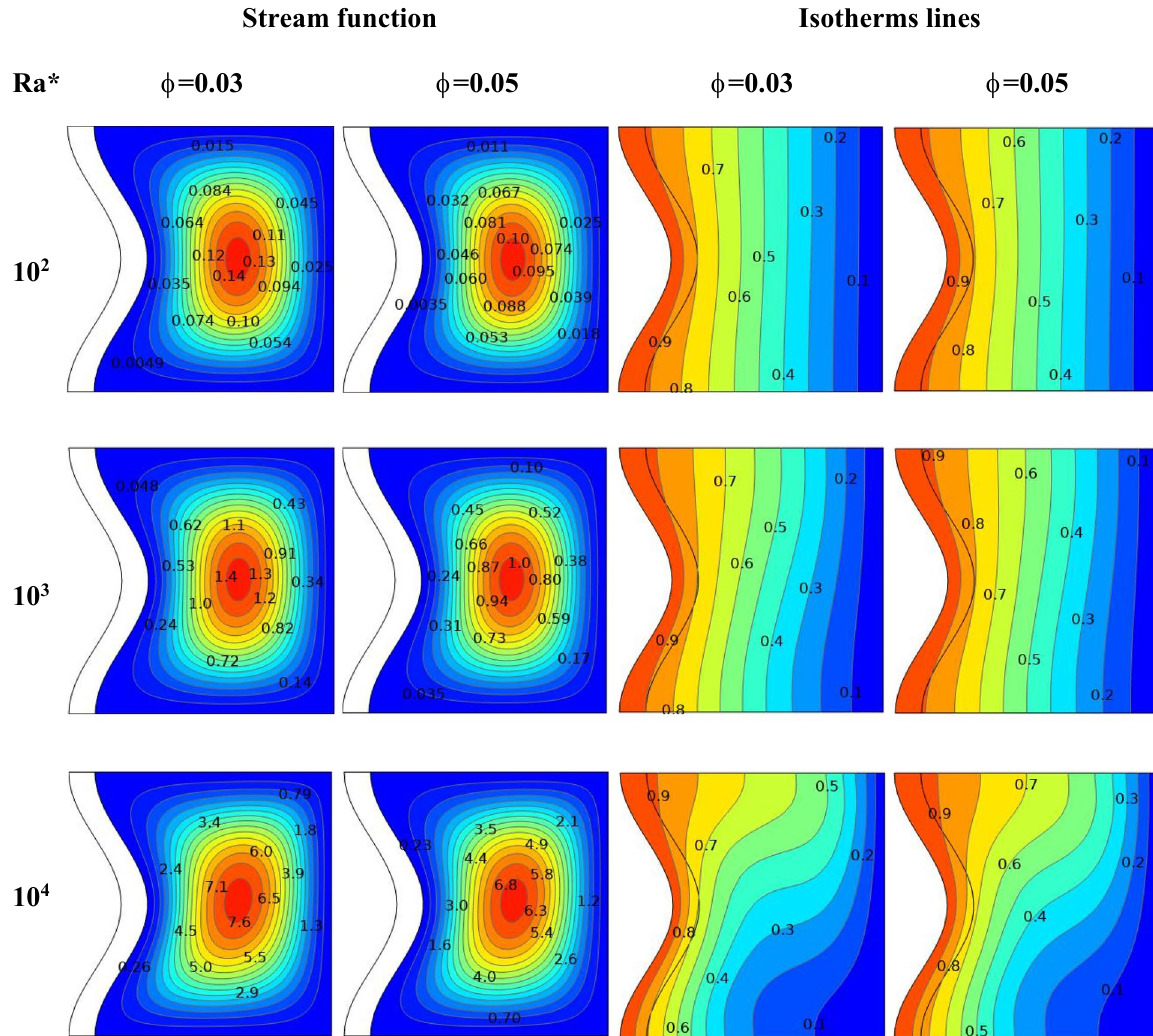
Figure 9. For varying values of solid volume fraction ϕ, the streamline and isotherm contours of Ra* are seen (Da = 10 –4 ε = 0.6 kr = 1, A = D = 0.1 and N =